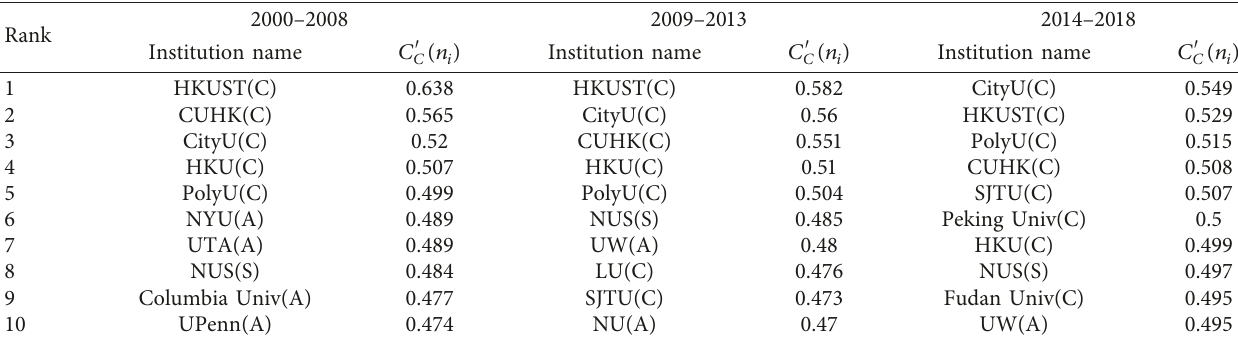
Table 8: The top ten institutions’ closeness centrality in three